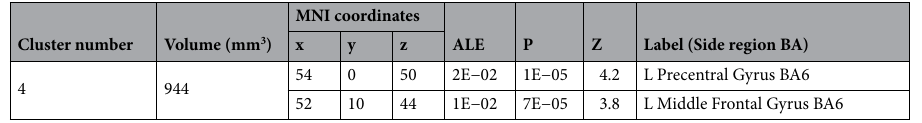
Table 2. Anatomic likelihood estimation meta-analytic results for music perception, production and imagery at cluster level inference p < 0.05 (FWE). ALE anatomic likelihood estimation, BA Brodmann area, P p-value, Z peak z-value, R right, L